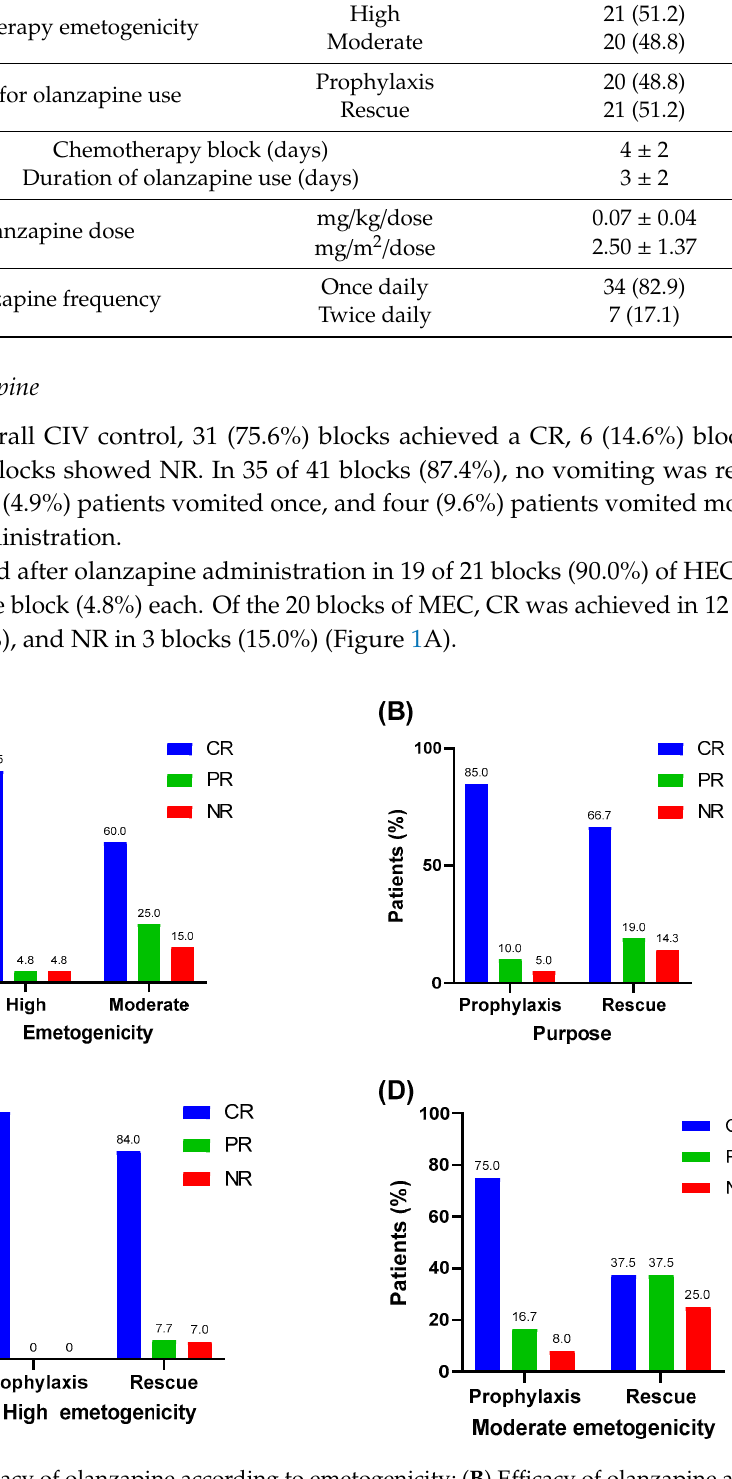
Table 2. Olanzapine use during chemotherapy blocks.